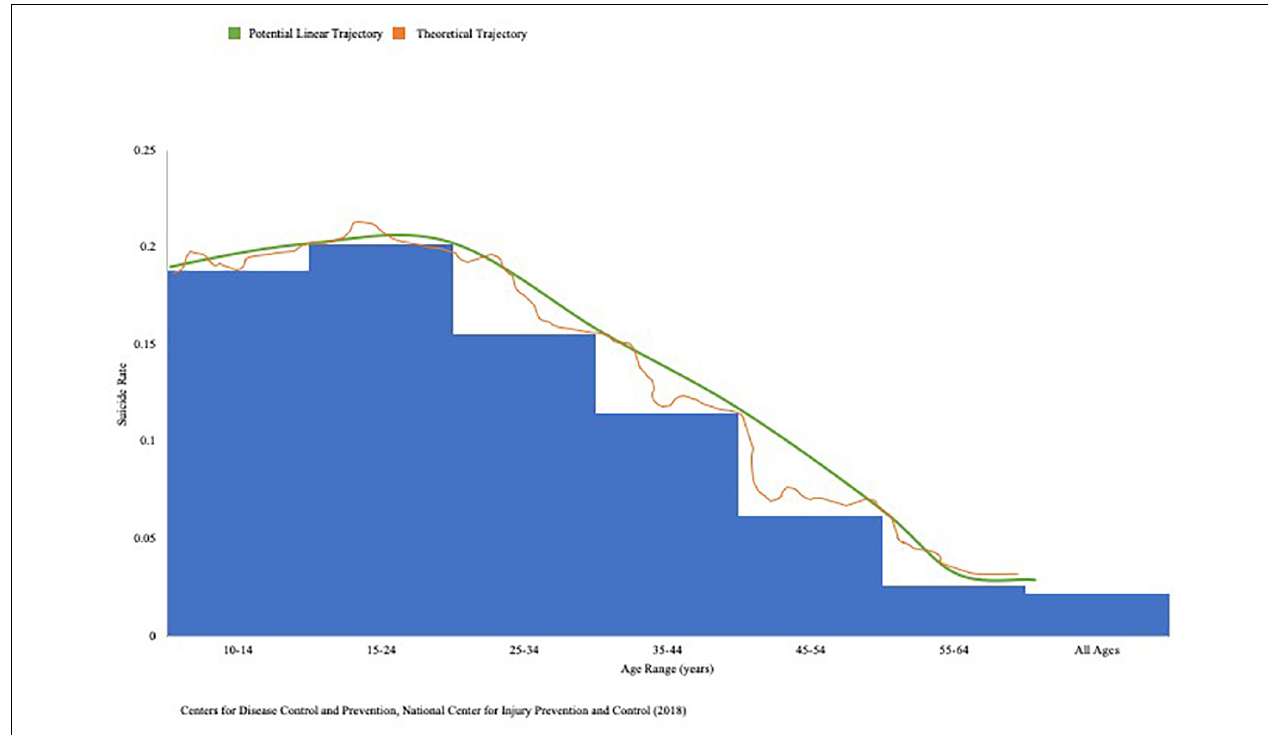
FIGURE 1 | 2016 suicide rates across age groups. Center for Disease Control and Prevention (CDC) WISQARS 2016 data on suicide deaths represented as ratio of total deaths attributable to top 10 causes of death in the United States, with superimposed potential linear and theoretical trajectories of suicide risk over time. This data was obtained through a unique, 1-year search via the National Center for Health Statistics, National Vital Statistics